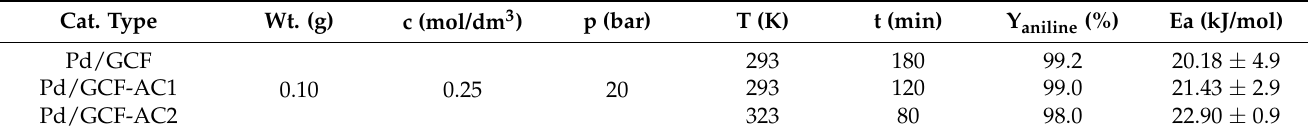
Table 4. Optimal synthesis parameters in case of each catalysts.